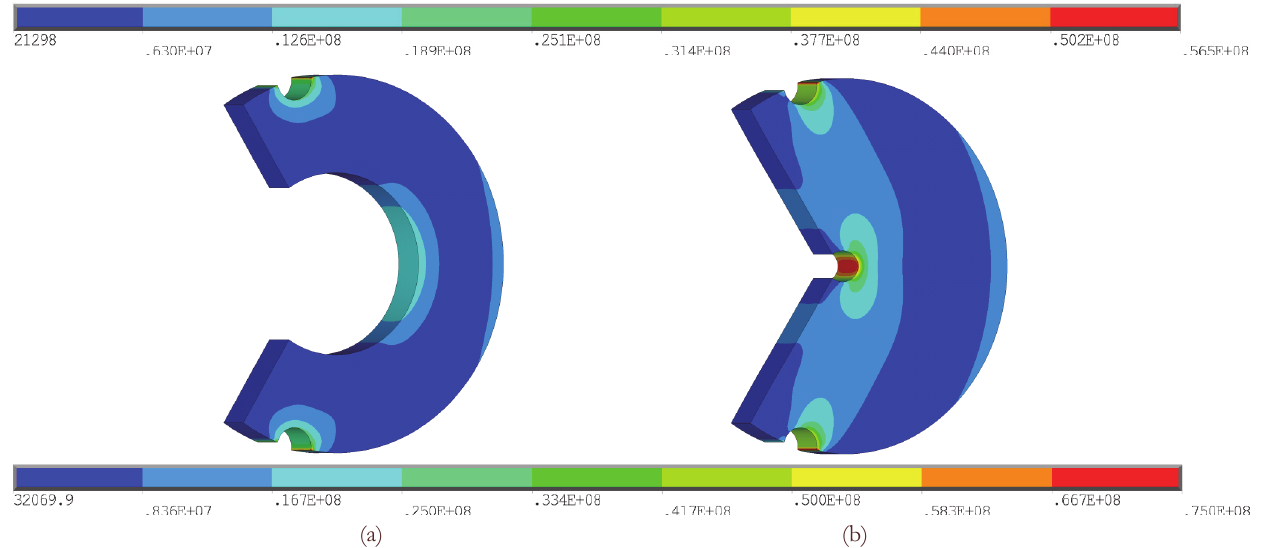
Figure 11: The distribution of the von Mises equivalent stress for a CSR with (a) ρ =2.0 (corresponding to the upper scale) and (b) ρ =10.0 (corresponding to the lower scale), for a common externally imposed displacement equal to 0.8 mm (scales in